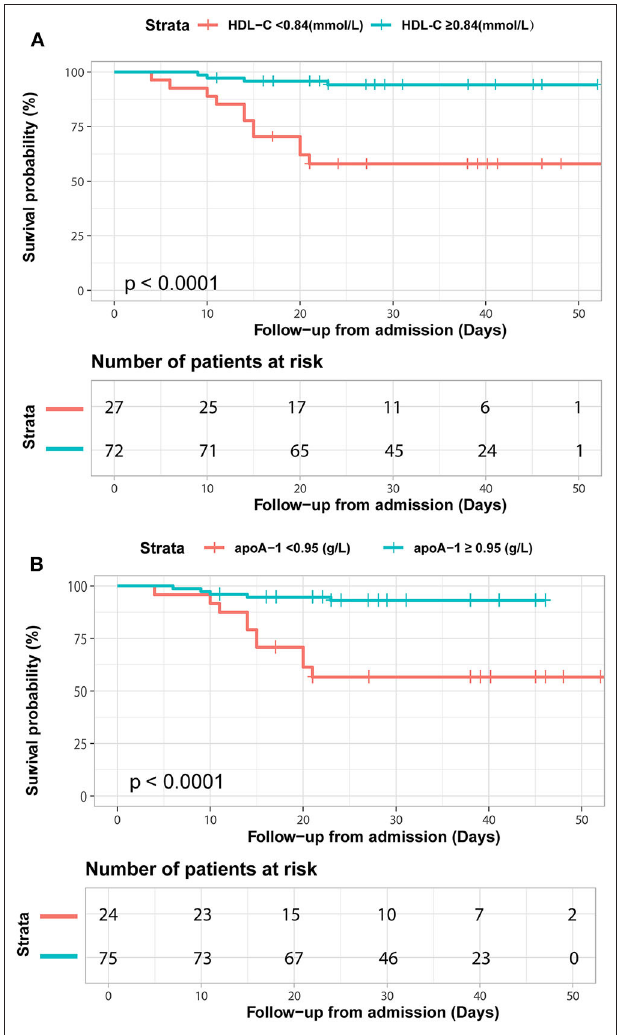
FIGURE 3 | Kaplan-Meier survival curves for in-hospital deaths based on dichotomized HDL-C and apoA-1 concentrations. COVID-19 patients with apoA-1 (A) and HDL-C (B) levels above and below the optimal cutoff value (calculated by ROC analysis) showed obvious disparity in survival time ( p <